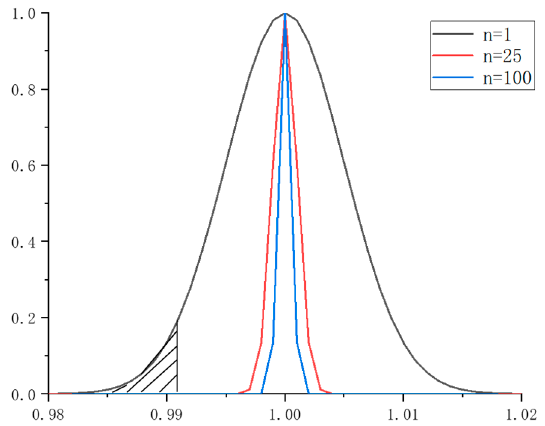
Figure 10. Sample random quantity normal distribution.